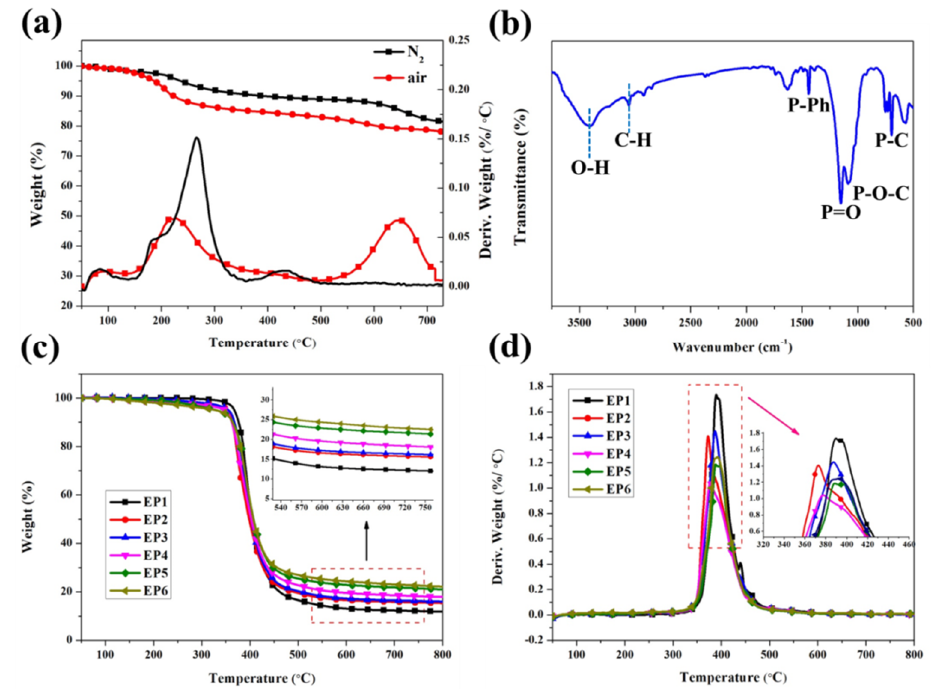
Figure 2. TGA and DTG curve of AHPP under nitrogen and air ( a ), FTIR spectrum ( b ) of AHPP, TGA ( c ) and DTG curves ( d ) of pristine EP and its composites under nitrogen. Table 2. TGA data for cured epoxy resin and its composites under N 2 atmosphere.